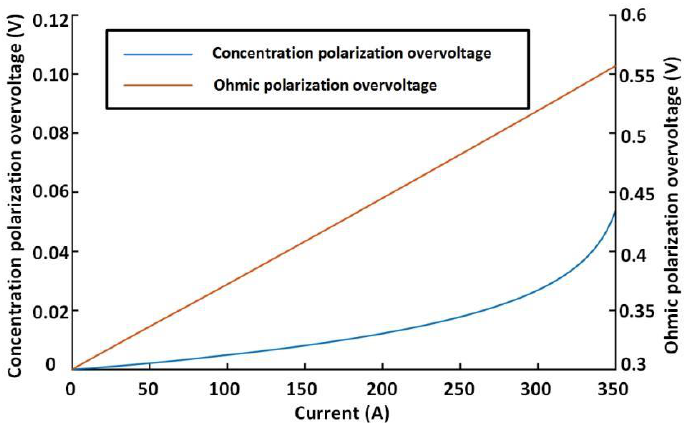
Figure 7. Electrochemical Nernst electromotive force and activation polarization overvoltage change with current.